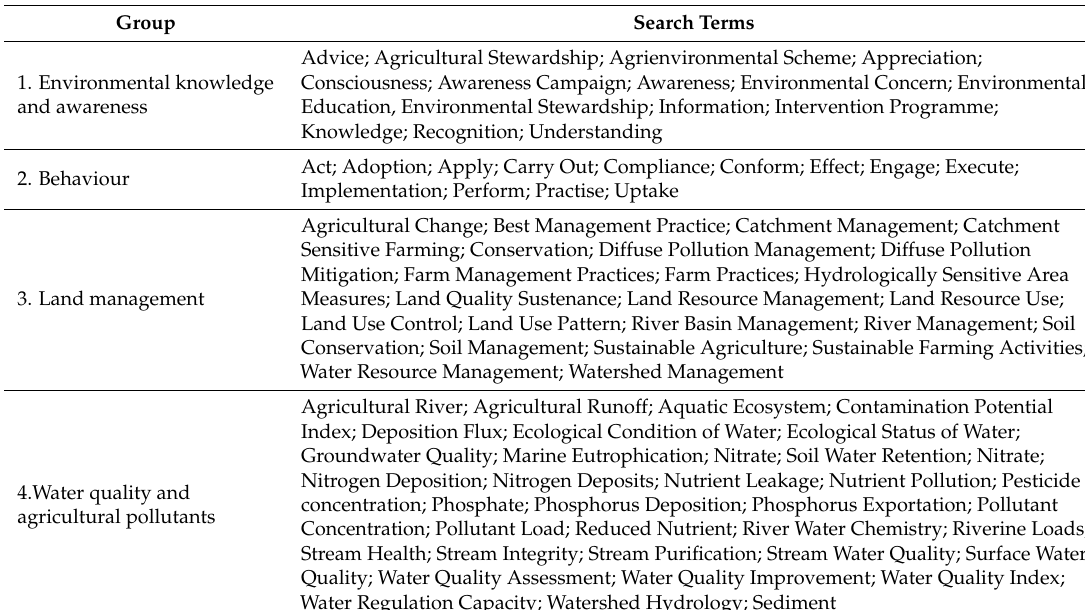
Table 1. Compilation of search